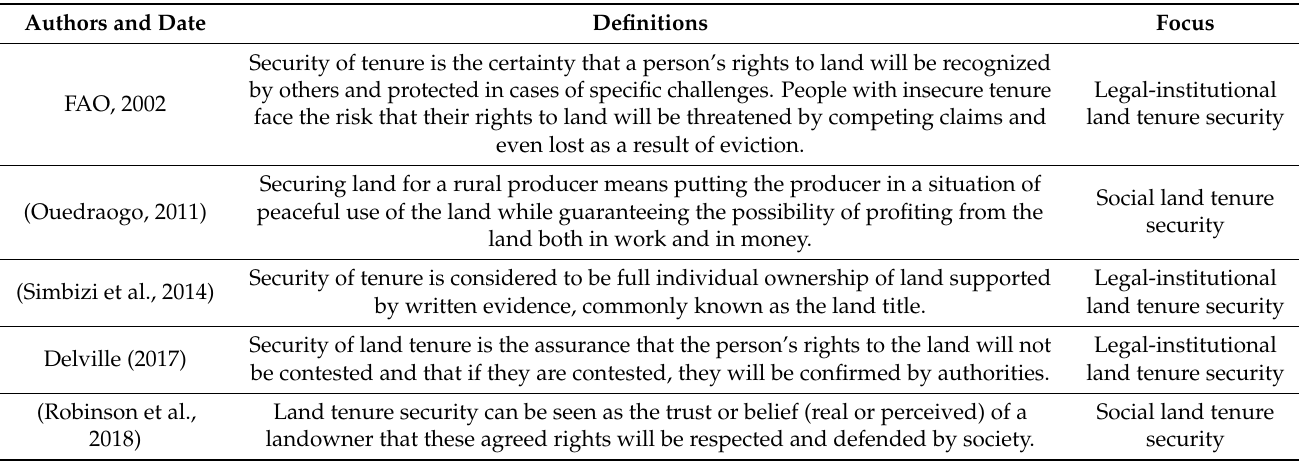
Table 1. Perception of the concept of land tenure security by the